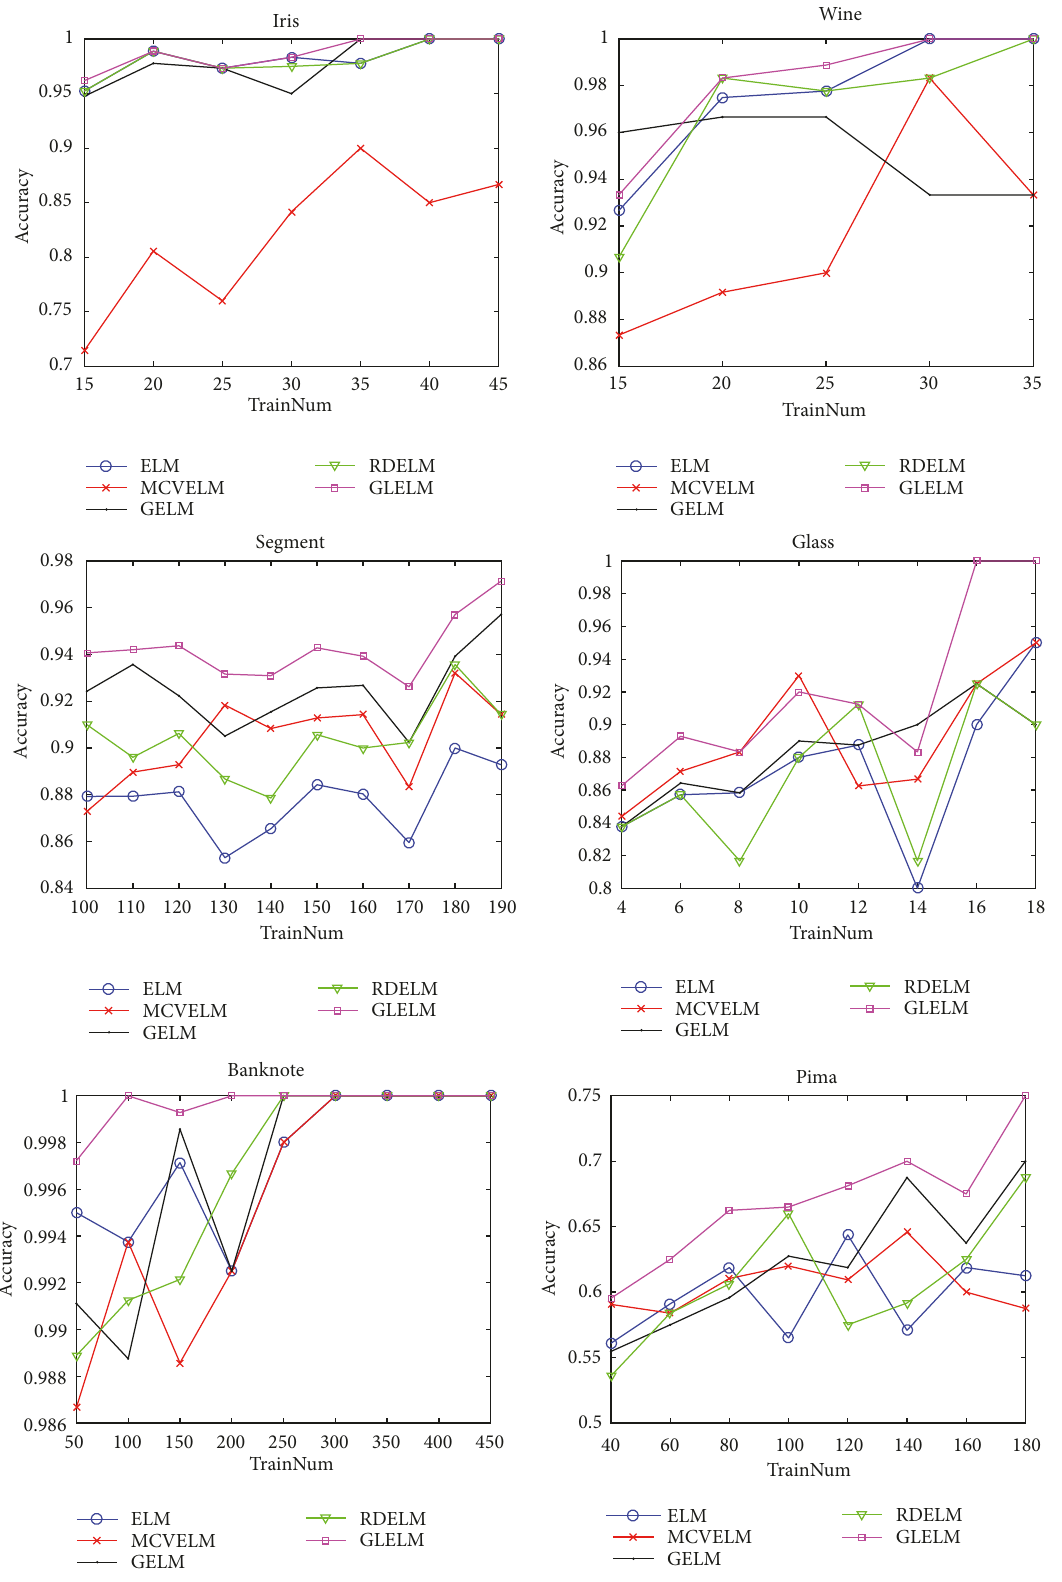
Figure 3: Identification rate curves of different ELM algorithms on UCI datasets Iris, Wine, Segment, Glass, Banknote, and